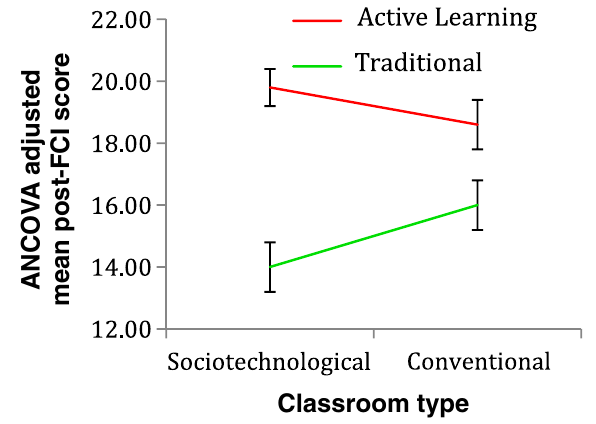
FIG. 2. Independent of classroom type, students in active learning pedagogies have significantly greater mean post-FCI score, when adjusted for pre-FCI score. Classroom settings alone do not contribute significantly to end of semester conceptual knowledge. Also, students in traditional pedagogies achieve better results in conventional classrooms than in sociotechnological classrooms. Error bars represent the standard error to the